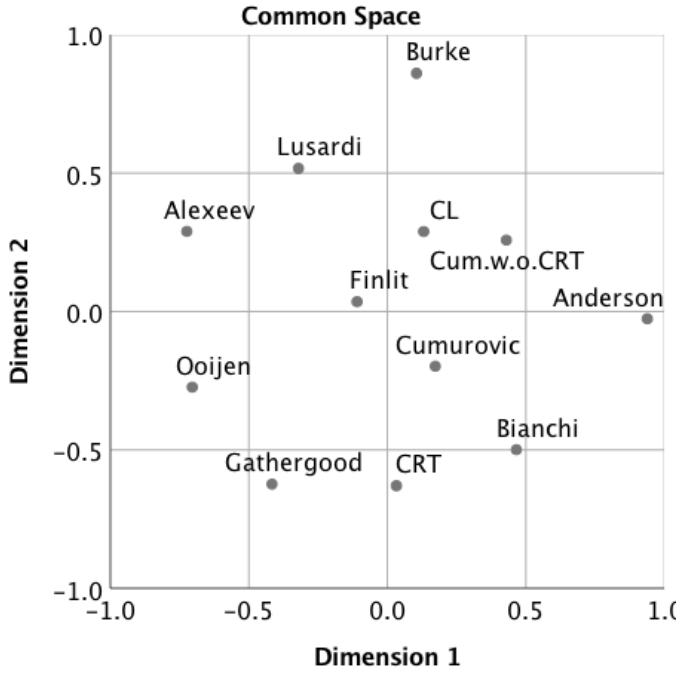
Figure 2. Multidimensional scaling of the different financial literacy measures shows that the joint scale by Lusardi and Cumurovic (without CRT) is the most representative scale for the total financial literacy (Finlit). We use PROXSCAL (PROXimity. SCALing), minimizing normalized raw stress, with ratio proximity